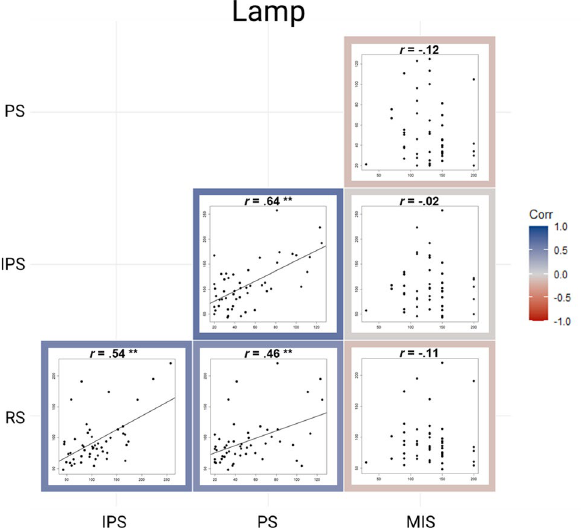
Figure 3. Correlation matrix plot showing the relation between RS, IPS, PS and MIS when facing the virtual lamp. The r refers to the Spearman coefficient when the correlation includes MIS and to the Pearson coefficient when it does not. ** p -values < .001, * p -values < .05.